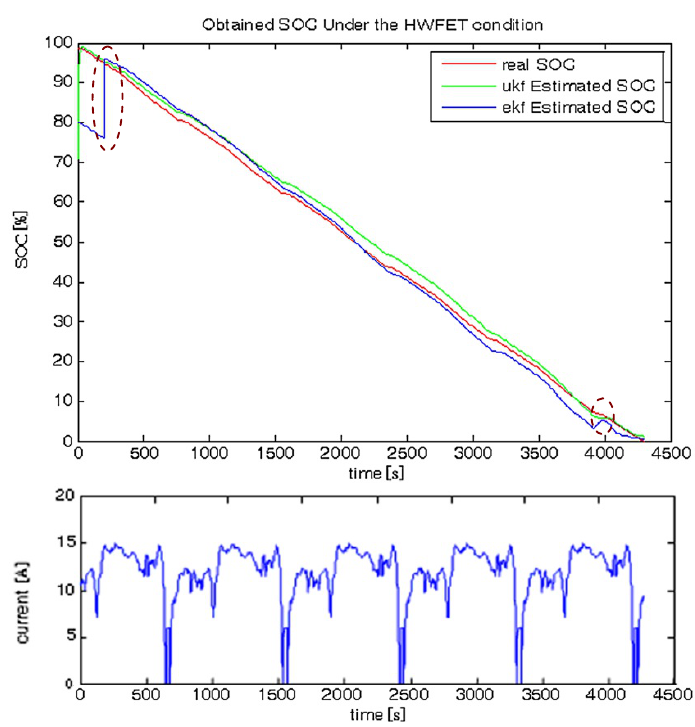
Figure 3. SOC estimation under the HWFET condition.